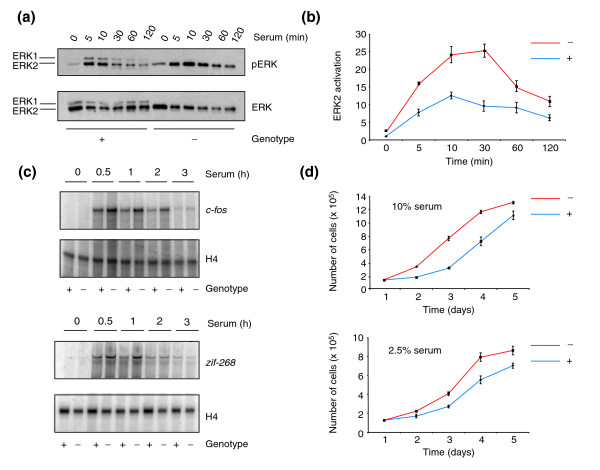
ERK1 ablation in mouse embryo fibroblasts results in enhancement of ERK2 activity and facilitates cell proliferation. (a) Wild-type (+) and ERK1-deficient (-) mouse embryonic fibroblasts (MEFs) were serum starved for 24 h and then stimulated with 20% serum for the indicated times. Western blotting was performed with both anti-ERK and anti-phospho-ERK antibodies. (b) Bands from (a) were quantified and the fold increase in phospho-ERK2 levels over total ERK2 levels calculated. (c) RNA from cells stimulated as in (a) was subjected to an RNase protection assay and probed for either c-fos or zif-268. A histone H4 probe was used as internal standard for normalization. (d) Wild-type (+) and ERK1-deficient (-) MEFs were seeded in triplicate in the presence of either 10% or 2.5% serum and cells were counted after the indicated times. Data are the mean ± standard error of the mean (SEM) of three independent experiments.